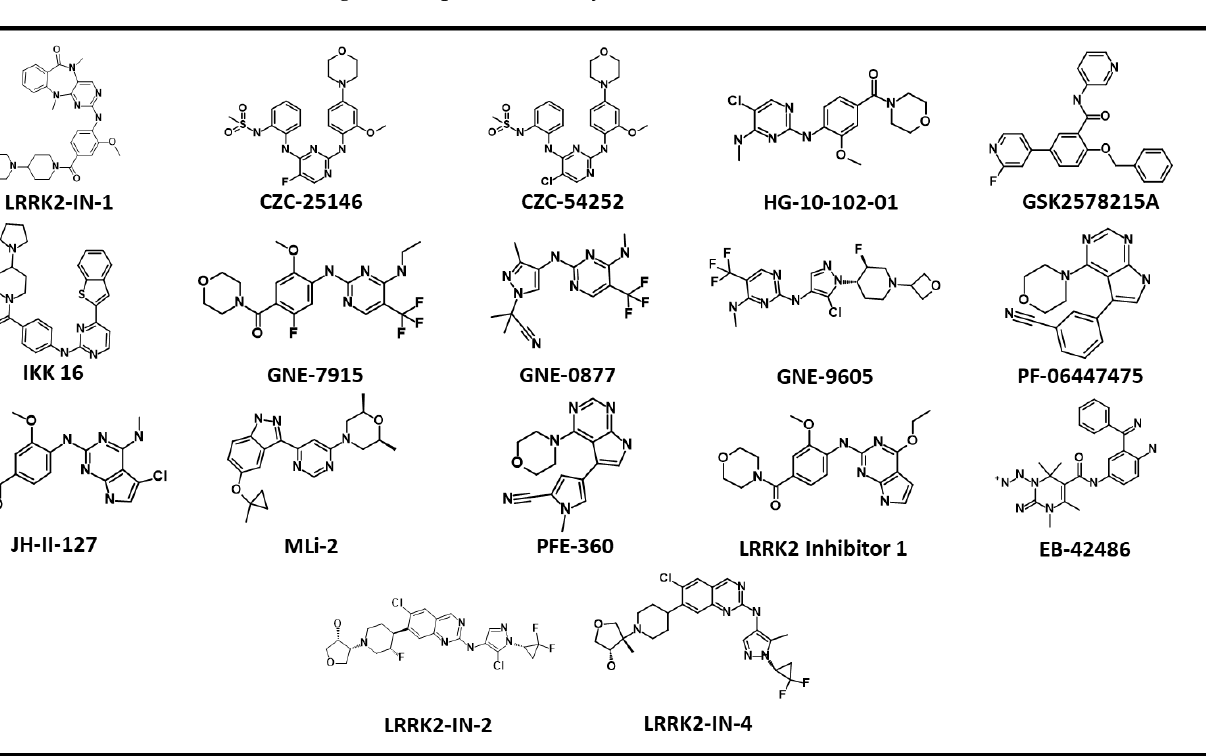
Figure 4. The 2D chemical structures of ATP competitive LRRK2 inhibitors.